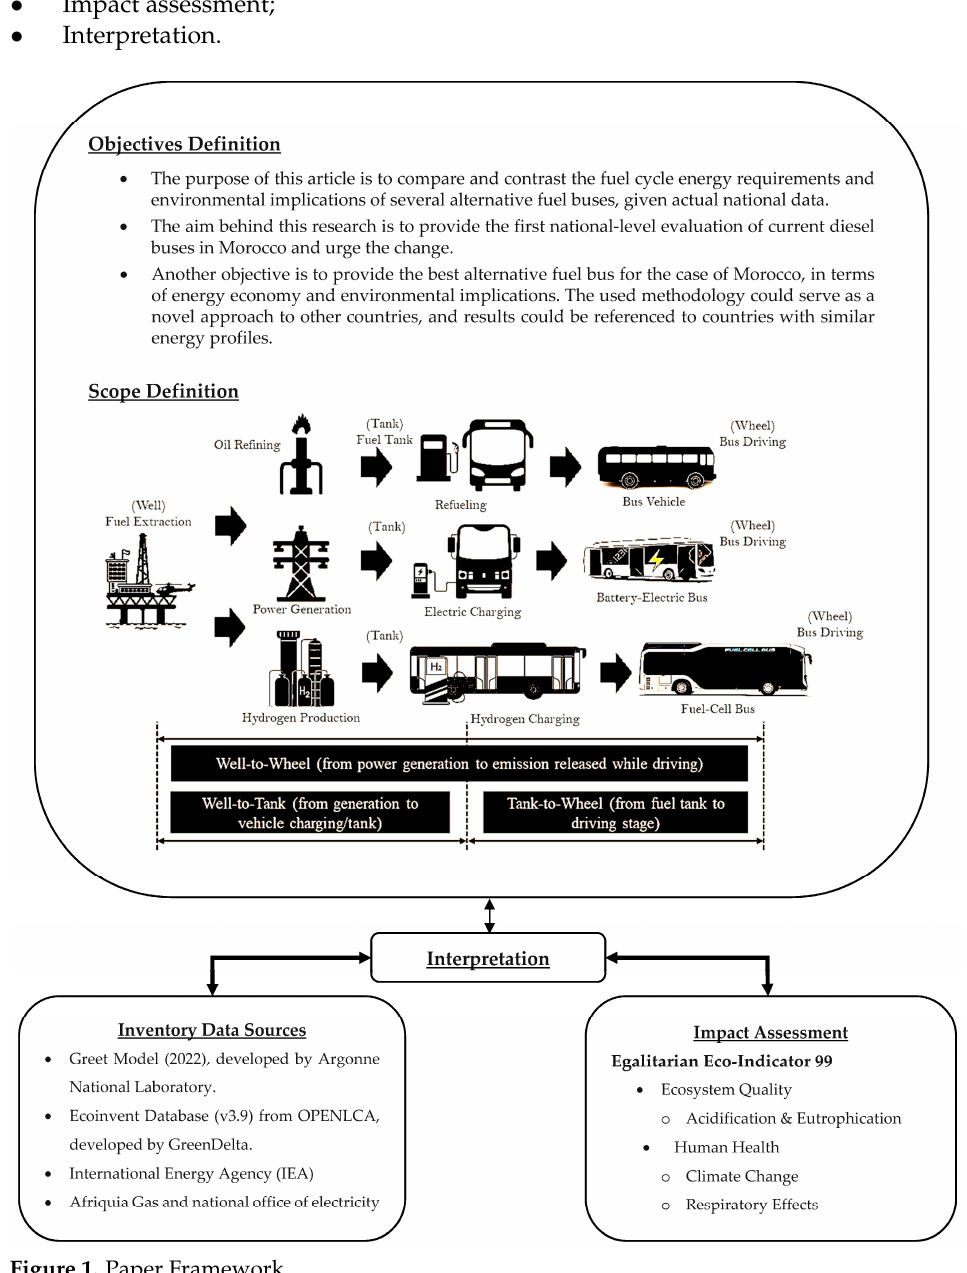
Figure 1. Paper Figure 1. Paper Framework.